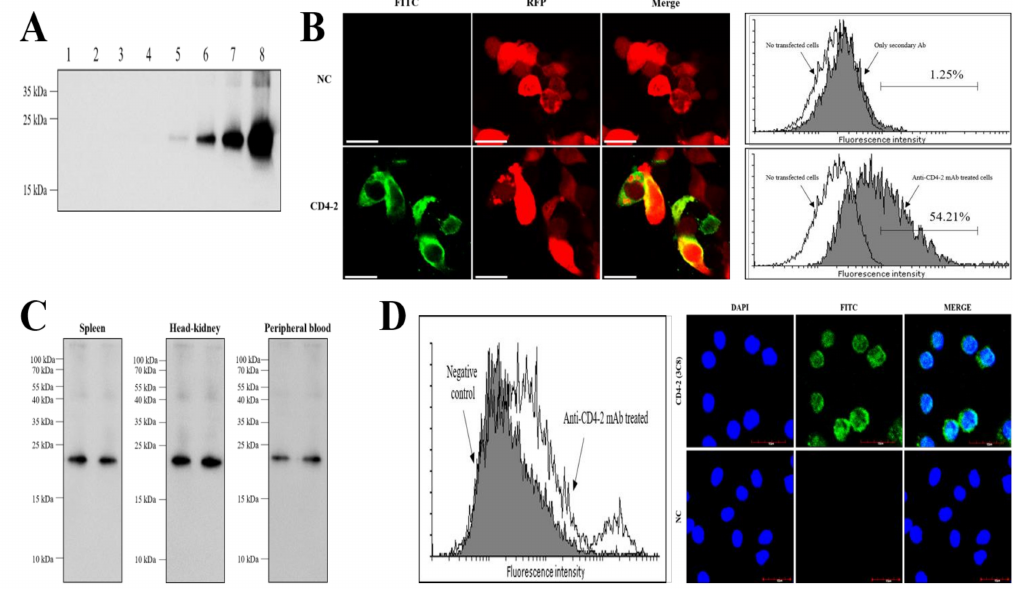
Figure 1. Identification of the anti-CD4-2 monoclonal antibody (3C8). ( A ) The antibody was screened for specificity and sensitivity against increasing amounts of recombinant CD4-2. Lane 1, rCD3 ε at 500 ng; Lane 2, rCD4-1 at 500 ng; Lane 3, rCD4-2 at 16 ng; Lane 4, rCD4-2 at 32 ng; Lane 5, rCD4-2 at 63 ng; Lane 6, rCD4-2 at 125 ng; Lane 7, rCD4-2 at 250 ng; Lane 8, rCD4-2 at 500 ng. ( B ) Reactivity of anti-CD4-2 mAb to transfected 293F cells stably expressing flounder CD4-2 molecules. Scale bar = 20 um. ( C ) Western blotting analysis of leukocyte cell lysates from spleen, head-kidney and peripheral blood of olive flounder using anti-CD4-2 mAb (3C8), followed by HRP-conjugated goat anti-mouse IgG. ( D ) Flow cytometry analysis of head-kidney leukocytes stained with anti-CD4-2-mAb. Negative control; shaded area, Anti-CD4-2-mAb treated; black line. Immunofluorescence staining of head-kidney leukocytes incubated with anti-CD4-2 mAb (3C8), followed by FITC-conjugated goat anti-mouse IgG. Immuno-reactivity appears